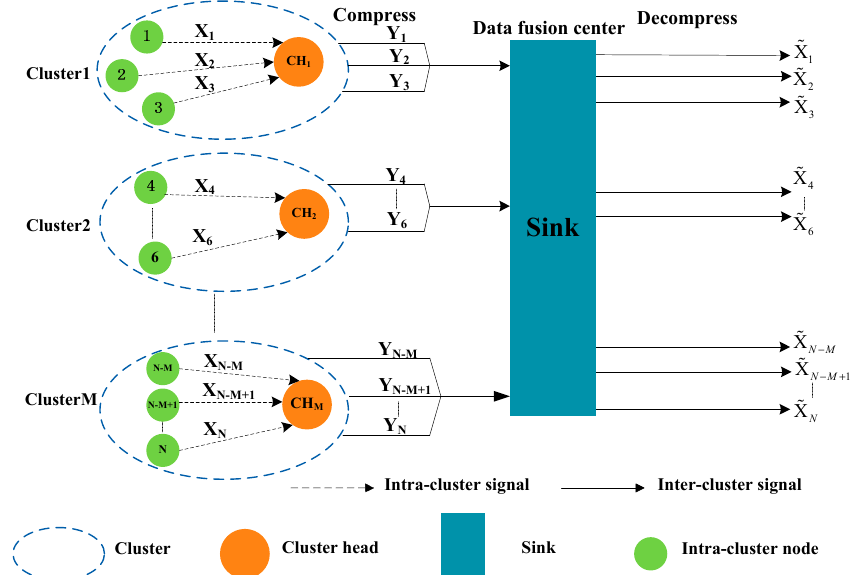
Figure1. Wirelesssensornetwork(WSN)systemmodelbasedonclusteringdatafusionwithcompressed Figure 1. Wireless sensor network (WSN) system model based on clustering data fusion with sensing compressed sensing (CS).